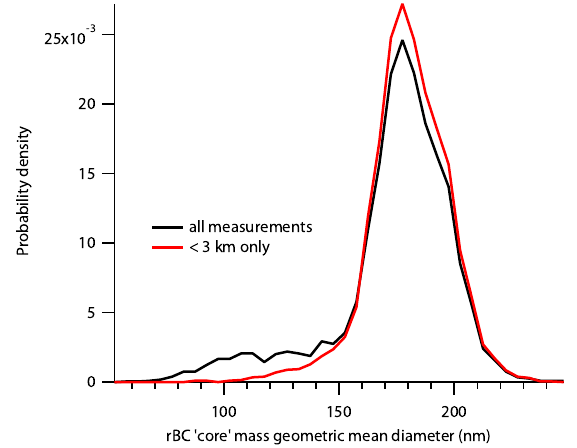
Fig. 10. SP2-measured refractory black carbon (rBC) “core” mass geometric mean diameters shown as a probability distribution func- tion (PDF) for all flights (black) and only periods when the aircraft altitude was below 3km (red). The 20–30s AMS-time series aver- aged data were used to determine the PDF. Both distributions peak in the bin spanning 175 to